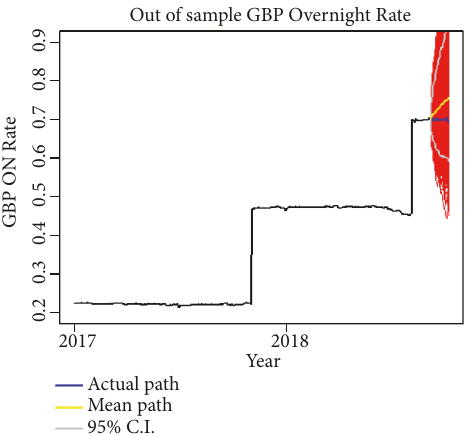
Figure 5: Visual Plot of the Simulated GBP ON LIBOR.